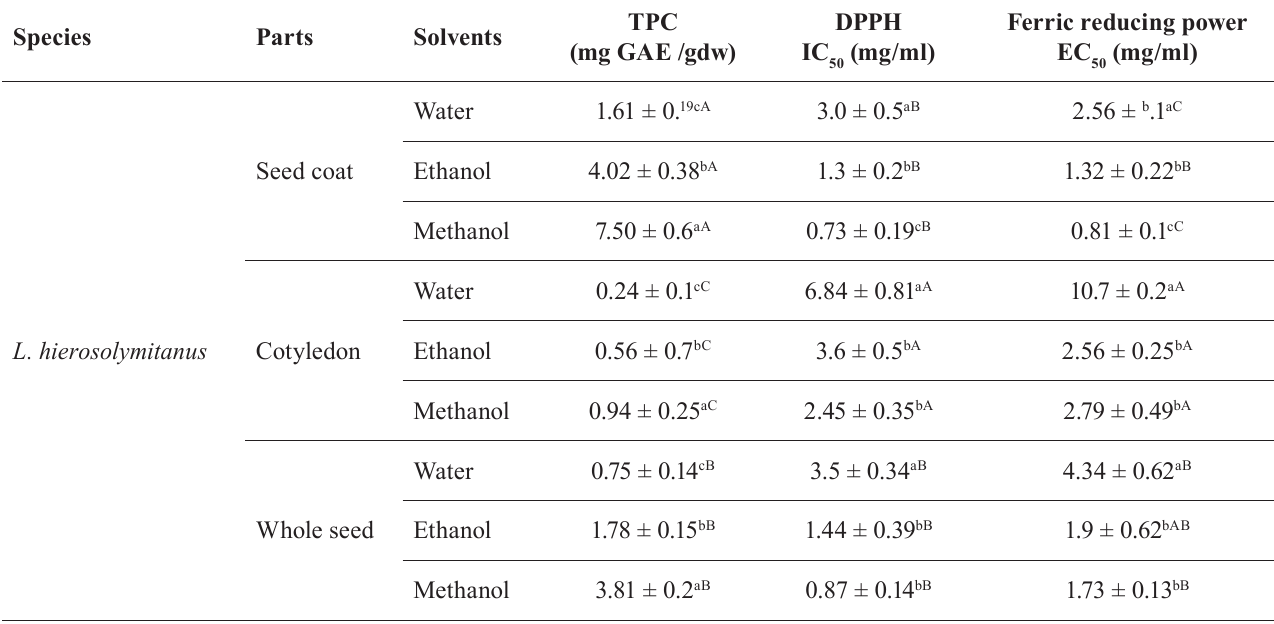
*Values are mean a standard deviation. Different letter within the same column show differences of means among different solvents for each part of each plant species (p < 0.05). Different caps letter shows differences between extracts from different part of the plant in the same solvent for Lathyrus species (p <